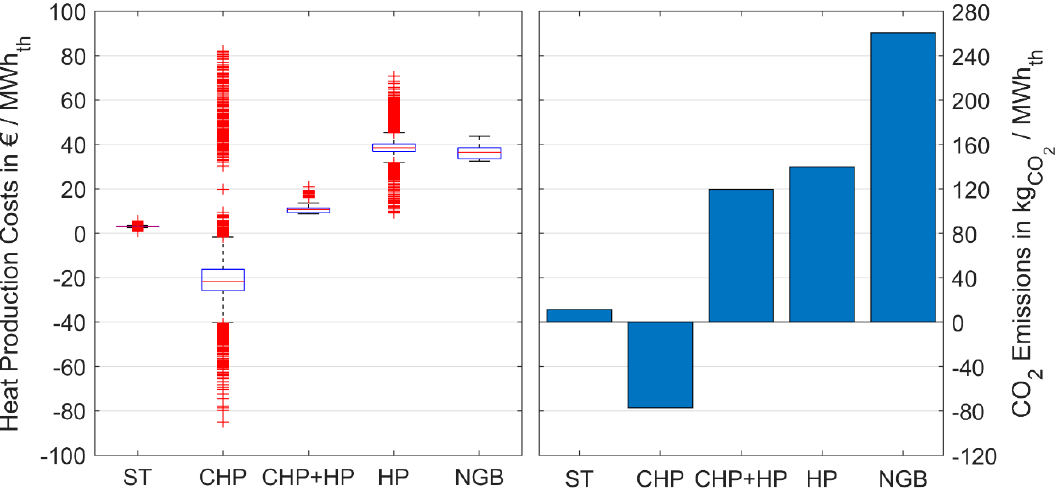
Figure 12. Scenario 1—Distribution of the heat production costs and values of CO 2 emission factors for different heat generators for the energy policy framework conditions in Germany based on data from 2017 and 2018, with KWKG and electricity credit method.